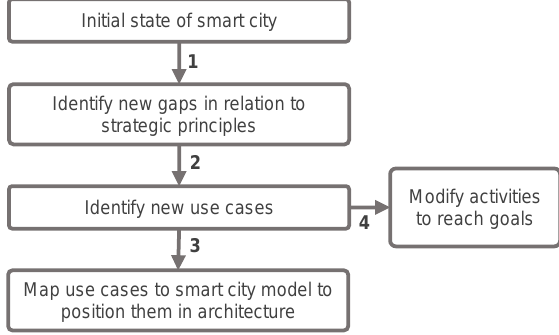
Figure 3. Identification and mapping of use cases inspired by (Gottschalk et al., 2017) 5.